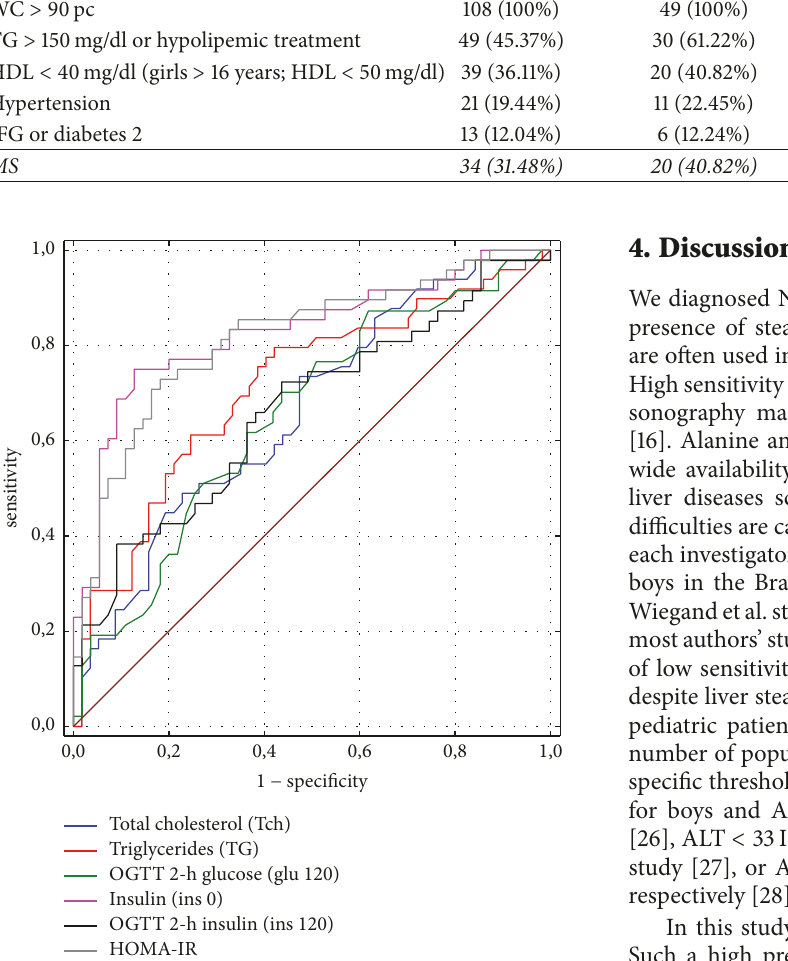
Figure 2: Comparison of ROC curves for parameters significantly differentiating patients with NAFLD from non-NAFLD